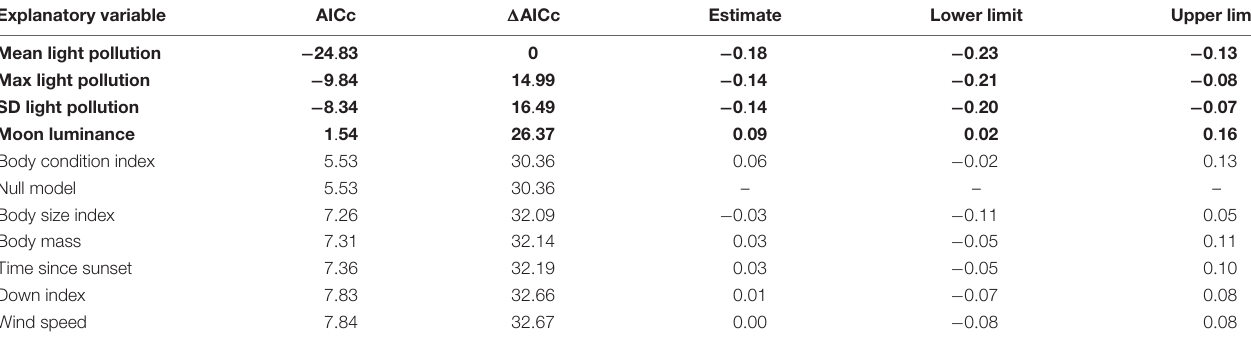
TABLE 5 | Univariate linear models explaining flight straightness ranked by AICc.